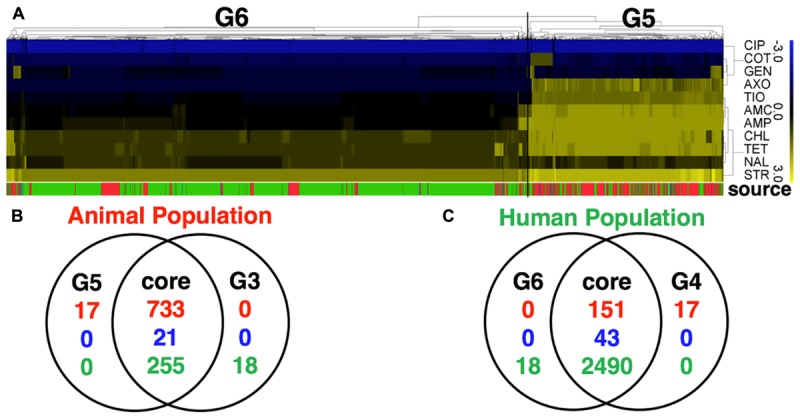
Comparative analysis of S. Newport population with a full panel of 27 antibiotics tested for all strains (with partially data missing) and a subset of 11 selected antibiotics tested for all strains (with no missing data). (A) The heatmap of MIC value of a subset of 11 core antibiotics for 3728 S. Newport isolates. A hierarchical tree with 200 bootstrapping, by using the MIC value of eleven core antibiotics, was used to group different population. Two populations detected, named G5 (isolates of animal origin) and G6 (isolates of human origin). (B,C) The Venn diagram showing the comparative difference between two groups, G5 (11 antibiotics) and G3 (27 antibiotics) of animal origin or between two groups, G6 (11 antibiotics) and G4 (27 antibiotics) of human origin. The figures show a very high consistency for the animal- and human-associated group, indicating that these two datasets for grouping S. Newport population have minor differences. The color of source shows the origin of individual strain, with red (animal), blue (meat), and green (human).